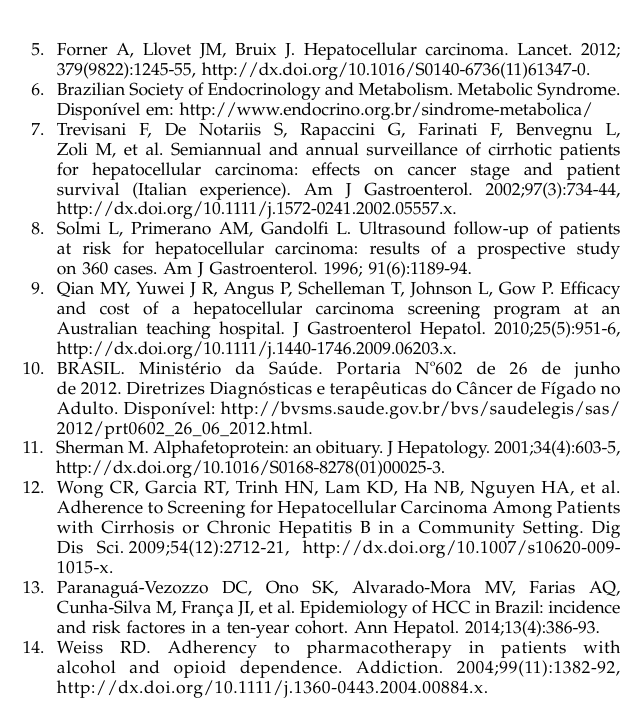
Table 4 - Number and size of hepatocellular carcinoma nodules diagnosed in cirrhotic patients by ultrasonography. Frequency of